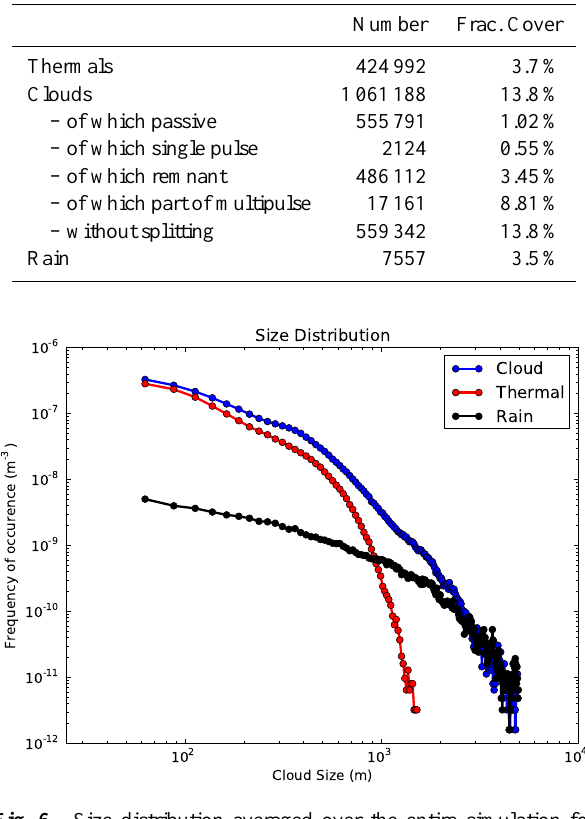
Fig. 6. Size distribution averaged over the entire simulation for clouds, thermals and